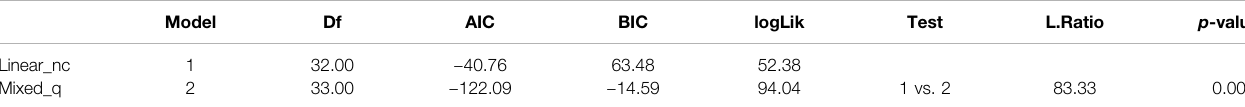
TABLE 3 | Comparison of the adequacy of linear and mixed-effects models.